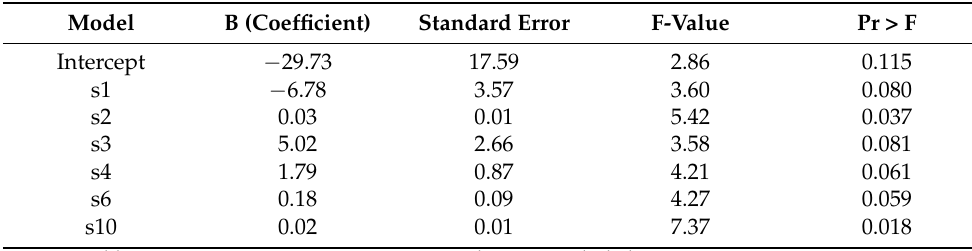
Table 6. Multiple linear regression analysis of meteorological elements and crude protein content in grains.